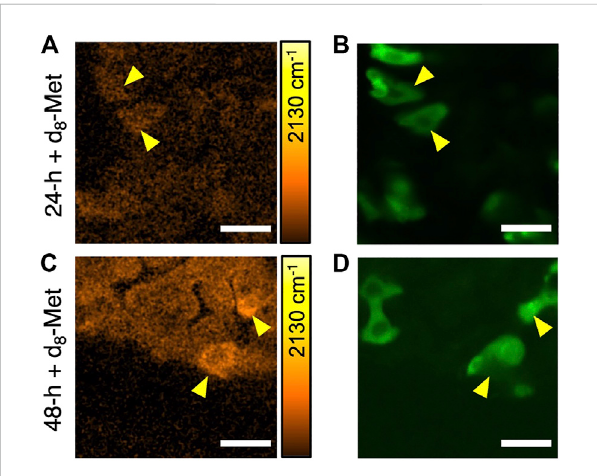
FIGURE 4 SRS and fl uorescence imaging of Drosophila larval fat body. (A) d 8 -Met uptake (orange), (B) LysoTracker (red) and (C) lipid (blue). The color bar corresponding to the d 8 -Met concentration shows maximum values of (A) 42 mM. Scale bars, 20 μ